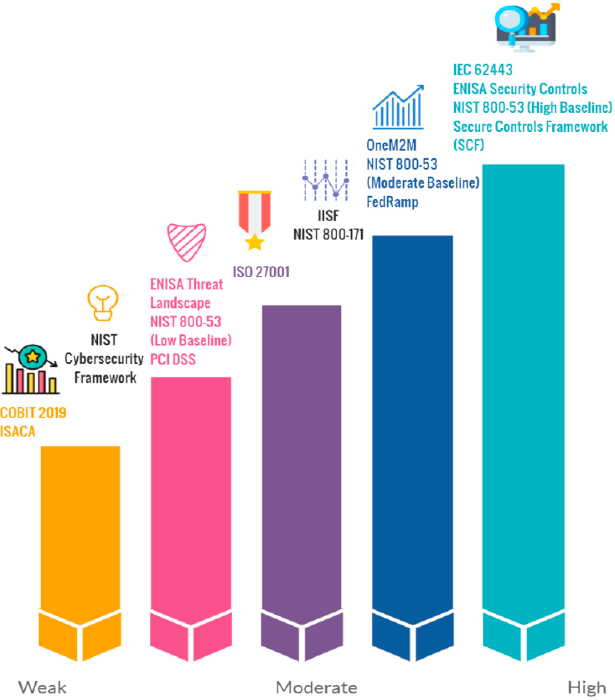
Figure 5. Cybersecurity standards coverage adapted from [40].